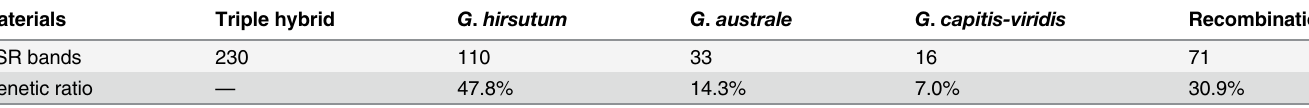
Table 2. The resources of the SSR polymorphism in trispecific